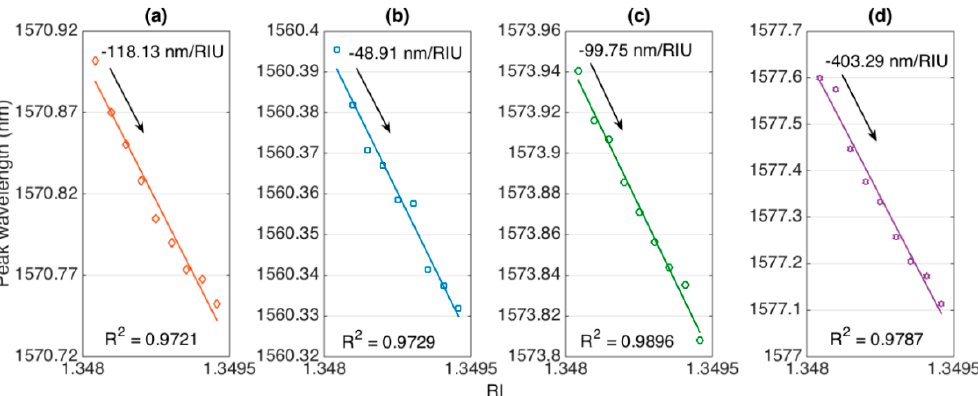
Figure 6. Evaluation of wavelength shift sensitivity for each ball resonator. The charts show the estimated peak wavelength for each interrogated spectral feature for different RI values (1.34798 – 1.34922). The sensitivity was evaluated as the slope of linear regression, R 2 = coefficient of determination. Ball resonator diameters: ( a ) 547 µm; ( b ) 532 µm; ( c ) 494 µm; ( d ) 466 µm.